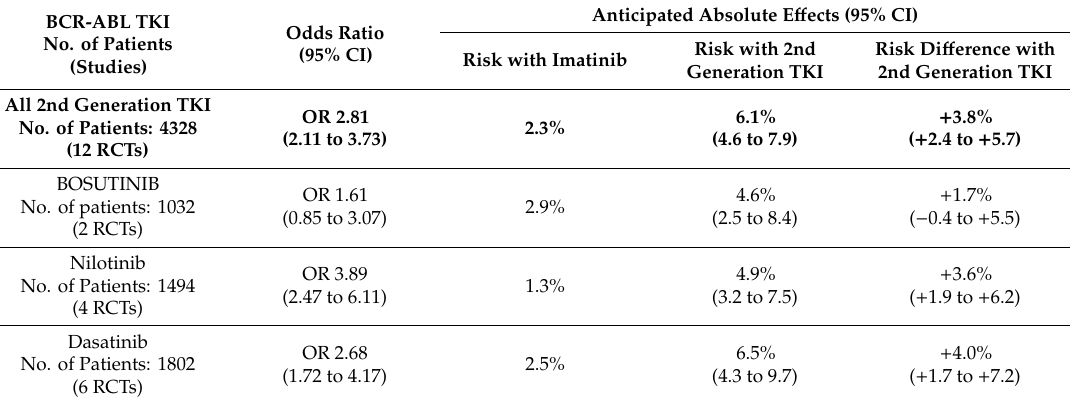
Table 2. Arterial occlusive events in patients with CML receiving second-generation BCR-ABL TKIs. (The bold is a summary of the other